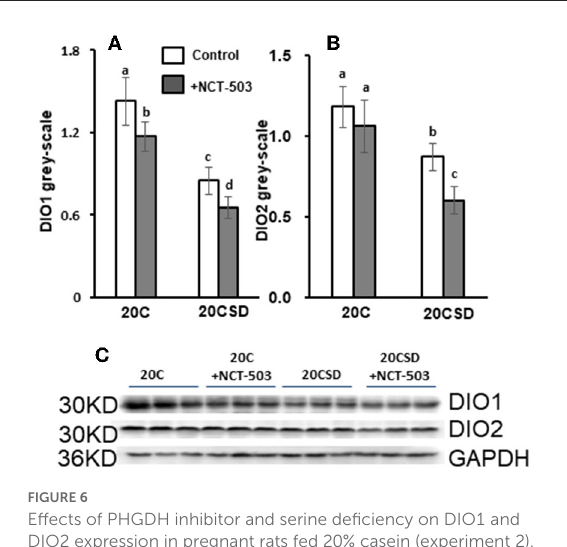
FIGURE6 Effects of PHGDH inhibitor and serine deficiency on DIO1 and DIO2 expression in pregnant rats fed 20% casein (experiment 2). Each value is the mean ± SEM. Means in a panel without a common letter differ, P < 0.05. DIO1, iodothyronine deiodinase 1; DIO2, iodothyronine deiodinase 2; GAPDH, glyceraldehyde-3-phosphate dehydrogenase.